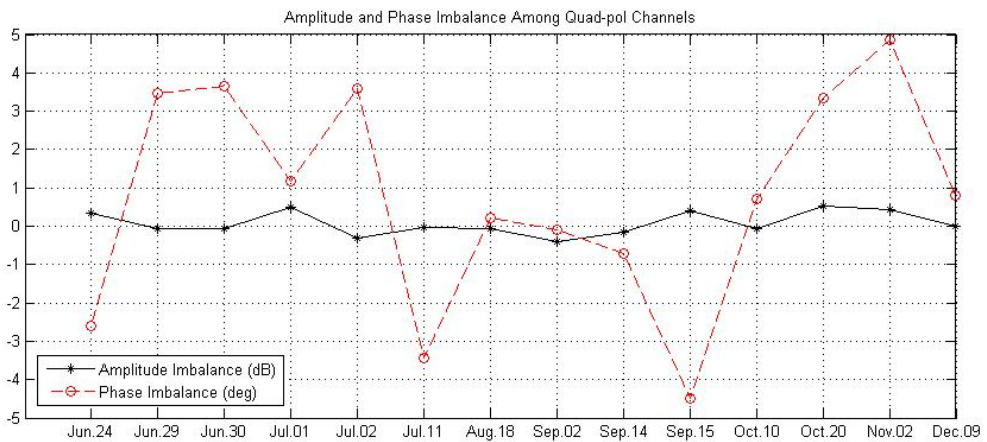
Figure 11. The amplitude and phase imbalance among quad-pol channels of full polarization stripmap mode of GF-3 after being in operational application.